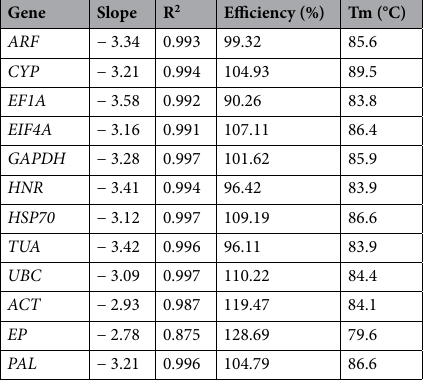
Table 2. Parameters derived from RT-qPCR analysis—slope, regression coefficient (R 2 ), reaction efficiency and melting temperature of the amplicon